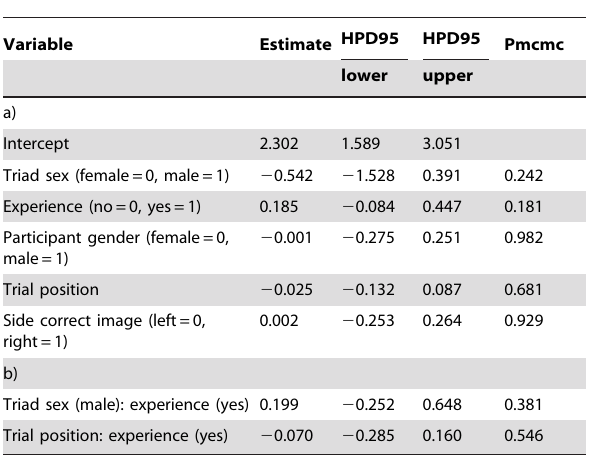
Table 1. Results of models examining performance in the individual discrimination task.